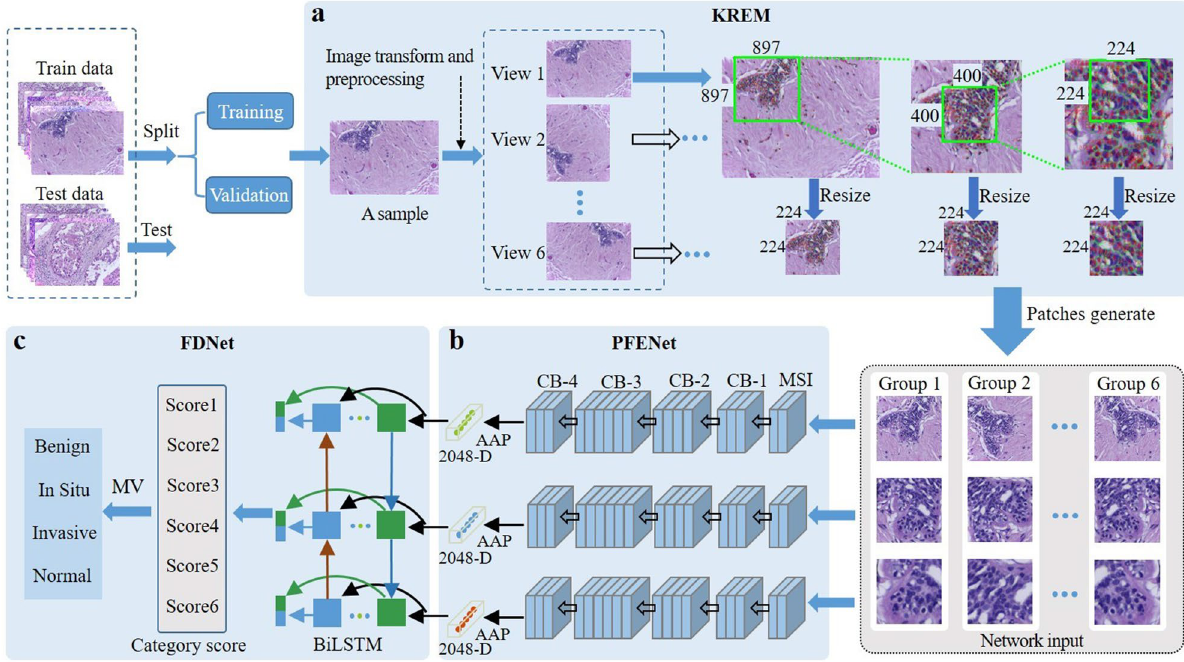
Figure 1. Diagram of breast cancer pathological image classification using MSMV-PFENet. ( a ) KREM. ( b ) PFENet. ( c ) FDNet. MSI: multi-scale input; PIL: preprocessing input layer; CB: convolution block; AAP: adaptive average pooling; D: dimensions; MV: majority